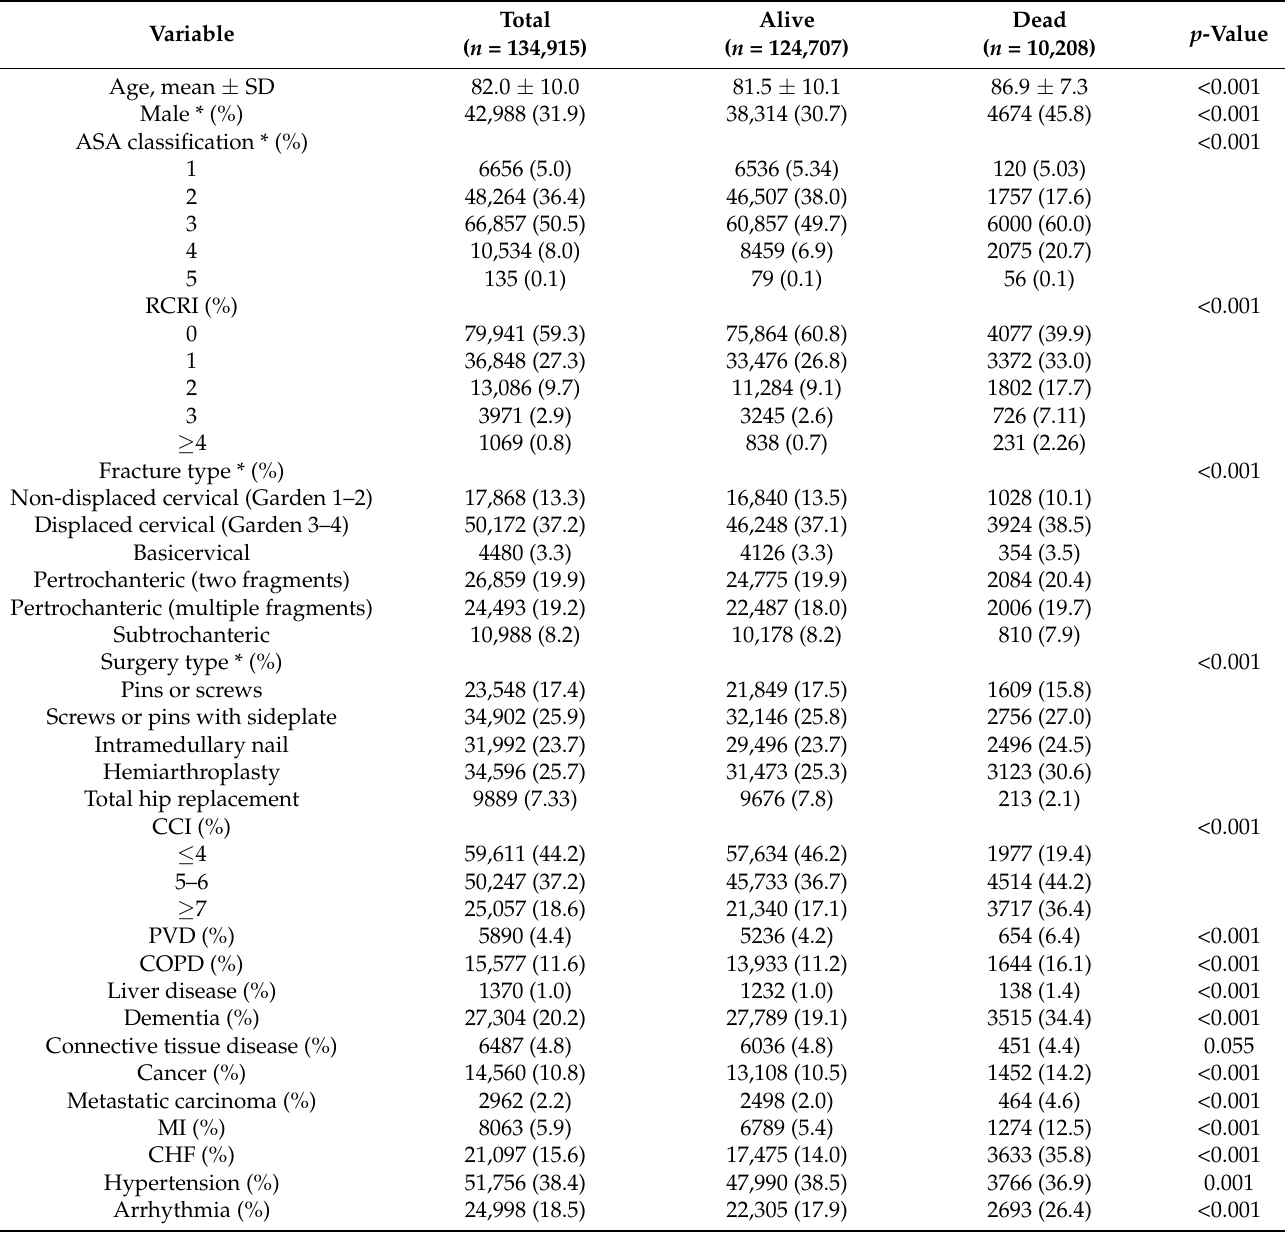
Table 1. Characteristics of the traumatic hip fracture patients in Sweden between 2008 and